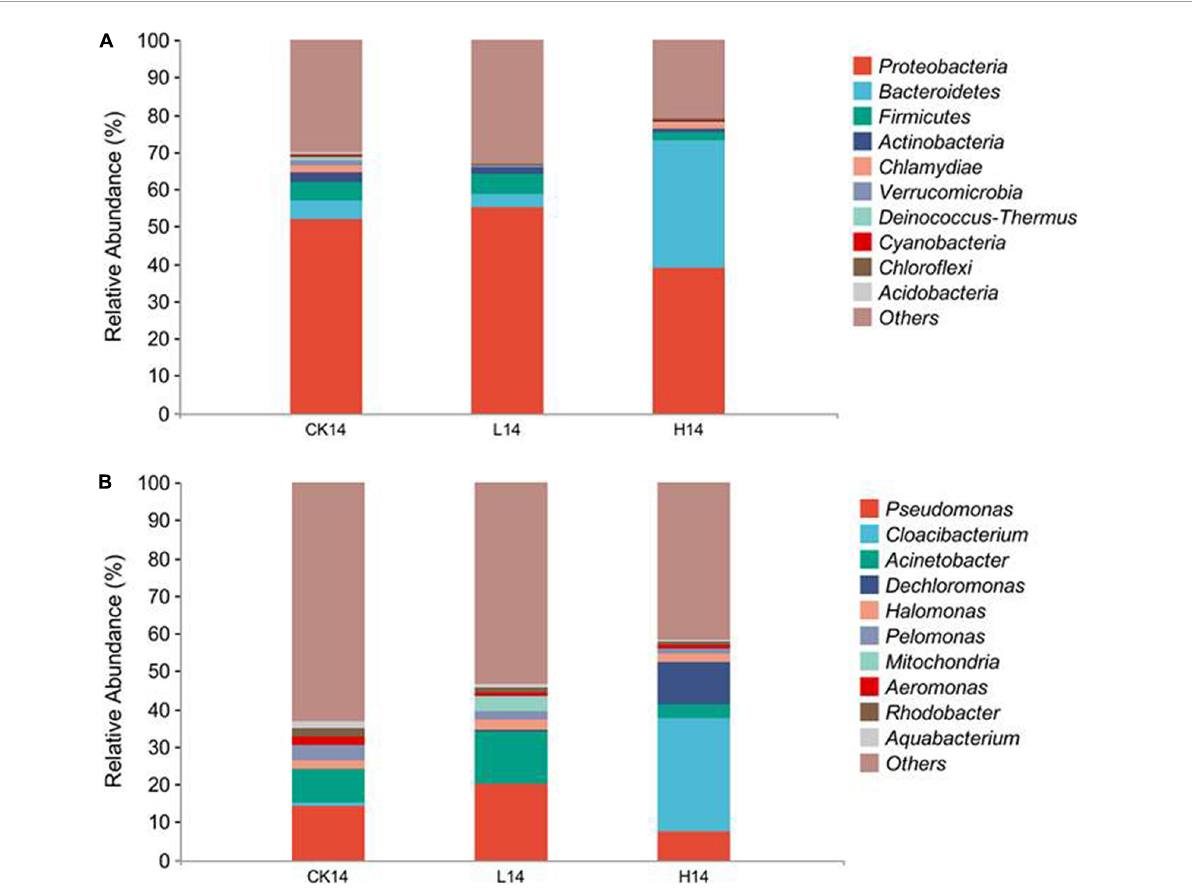
FIGURE3 Compositions of the intestinal microflora among the control (CK14), 0.5 mg/L (L14), and H14 (1.5 mg/L) treatments. (A) Compositions of the intestinal microflora at the phylum level. (B) Compositions of the intestinal microflora at the genus level. The top ten abundant genera (higher than 1% in at least one sample) are shown in the figure and the rest are indicated as